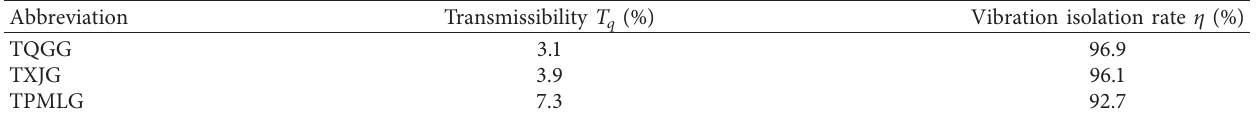
Table 5: The transmissibility and isolation rate of the combined isolation